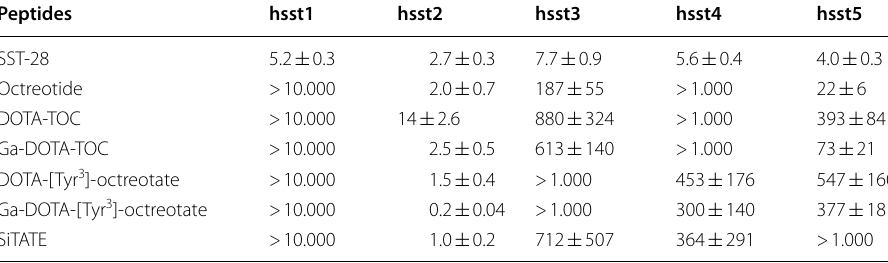
IC 50 SEM in nM (n ±